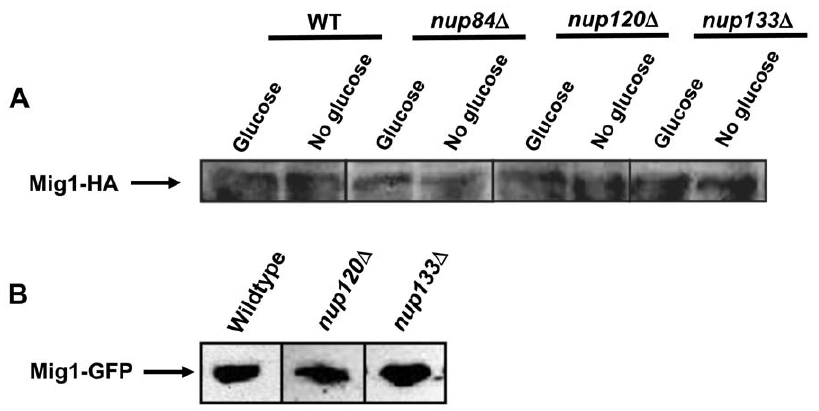
Figure 5. Levels of the Mig1 protein are not reduced in the absence of NUP120 or NUP133 . (A) Levels of HA-tagged Mig1 in crude lysate isolated from wild type, nup84 D , nup120 D , and nup133 D cells grown in media containing glucose (repressing conditions) or pyruvate (derepressing conditions) as the carbon source. (B) Levels of GFP-tagged Mig1 in crude lysate isolated from wild type, nup120 D , and nup133 D cells grown in media containing glucose as the carbon source (repressing conditions). 100 m g total protein in each